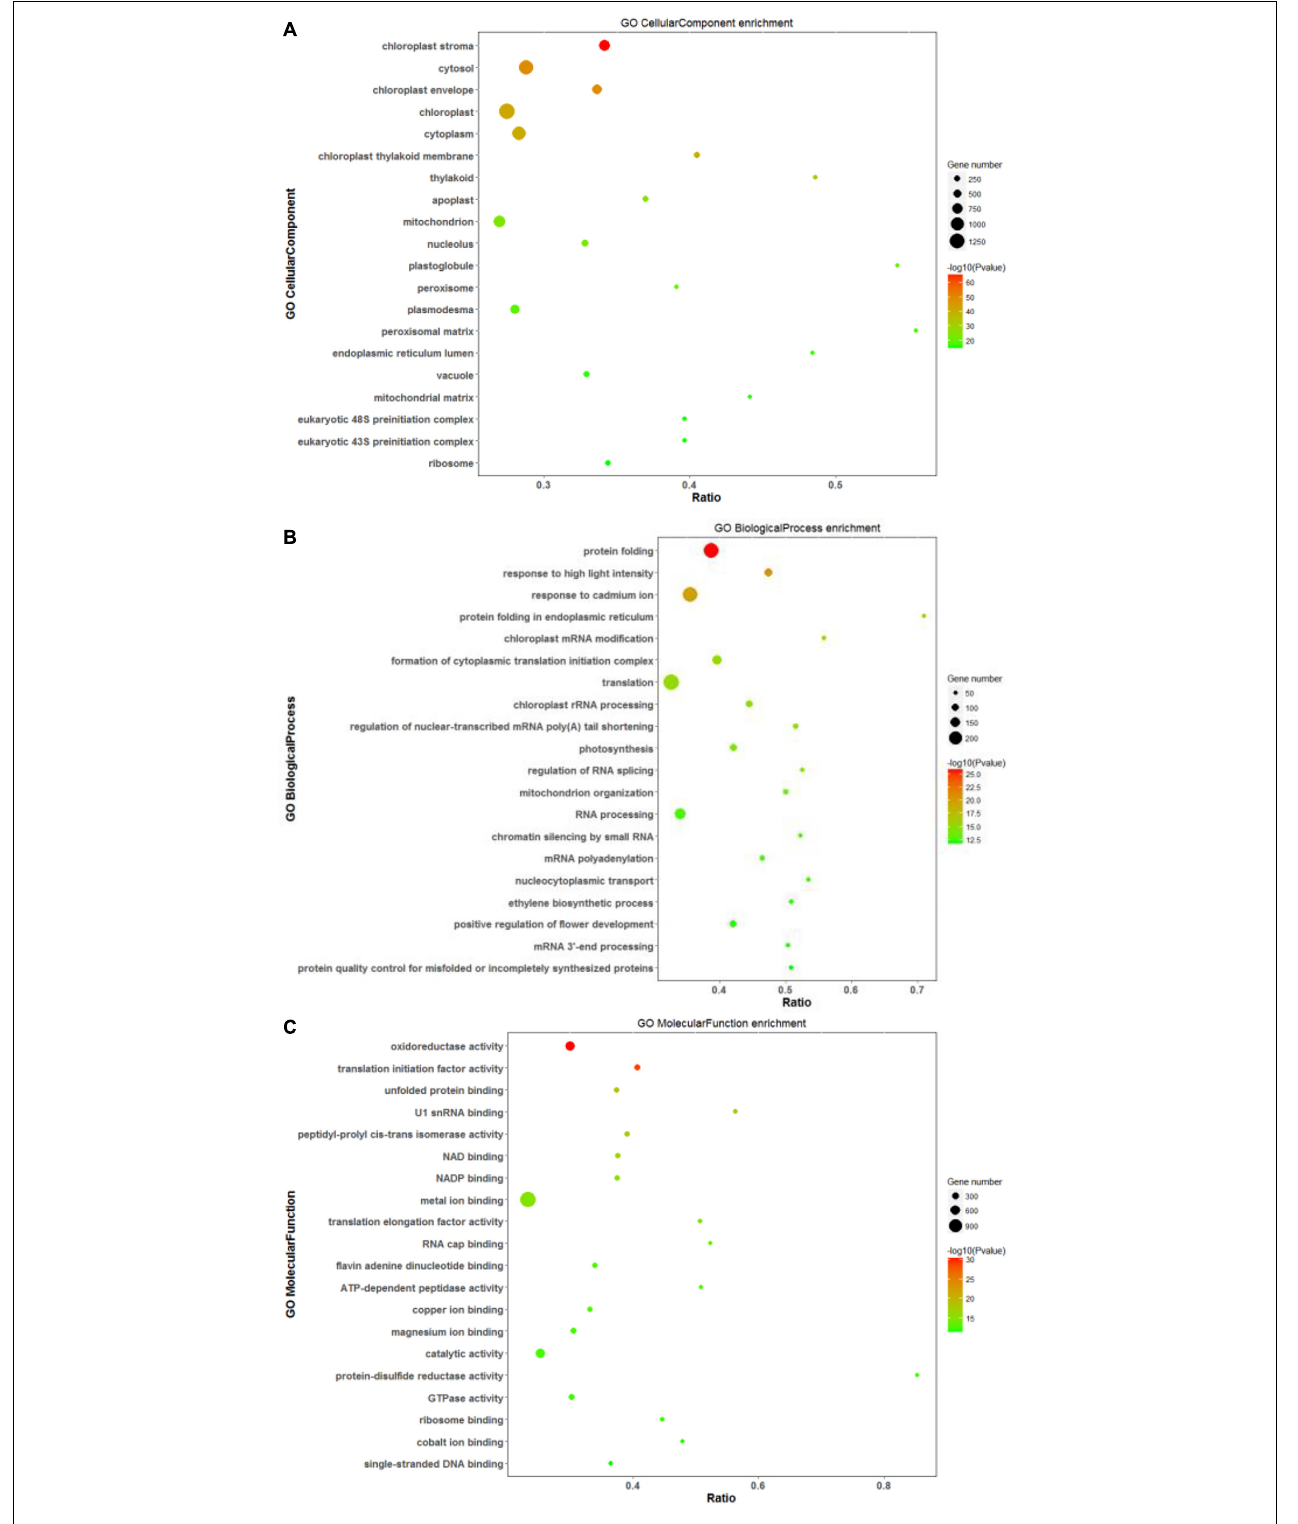
FIGURE 7 | Scatter diagram of gene ontology (GO) classification for DEPs. In this scatter diagram, the top 20 GO terms in the cellular component (A) , biological process (B) , and molecular function (C) categories are presented. The X-axis corresponds to the ratio (DEPs in this term to all the proteins in this term), and the Y-axis represents a different term. The magnitude of the dots displays the number of proteins, and the q-value is described by the color classification.